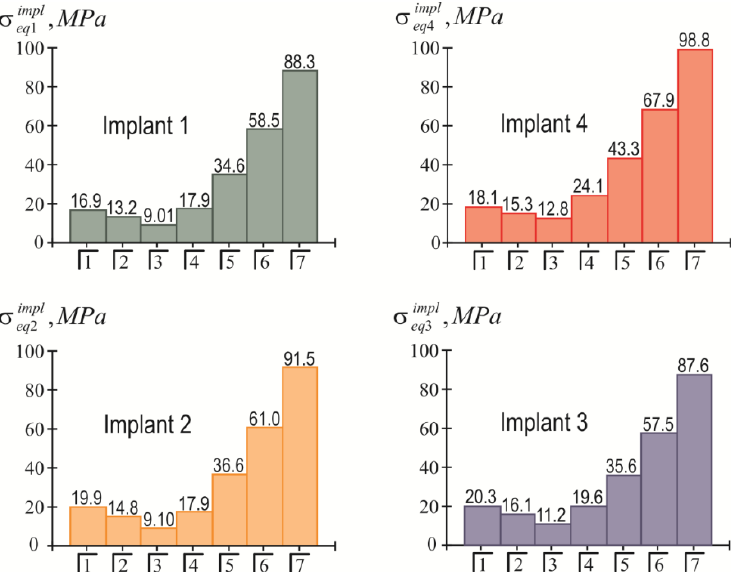
Figure 13. Dependence of maximum equivalent stresses in implants on the localization of the mastication load (the second variant of implant placement).